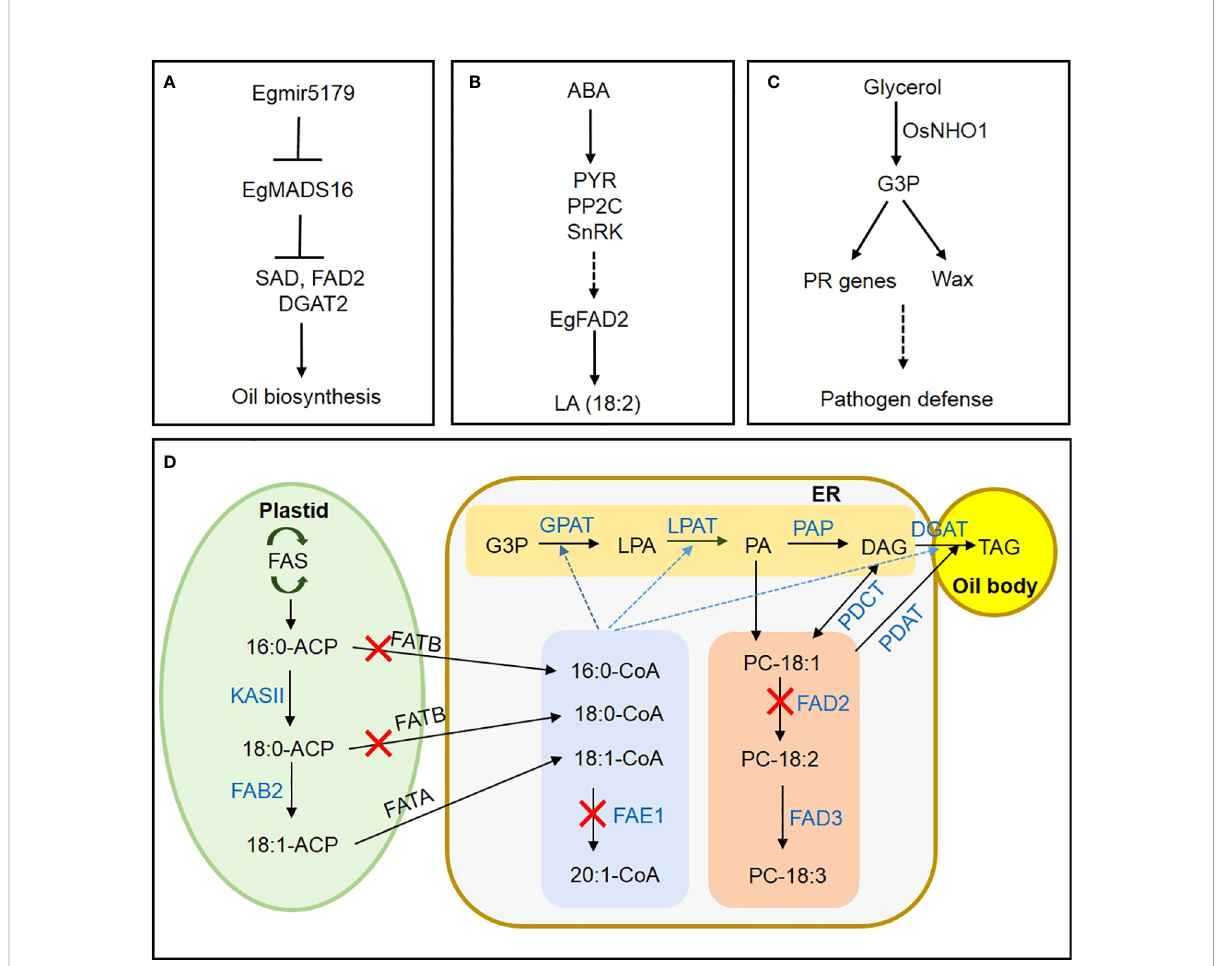
FIGURE 1 A novel mechanism for regulating lipid metabolism in oil crops and a metabolic pathway for FA and TAG synthesis in oilseeds. (A) In oil-palm mesocarp, mir5179 inhibits MADS16 expression and regulates the expression of oil synthesis genes SAD , FAD2 , and DGAT2 . (B) ABA induces linoleic acid synthesis through ABA signaling pathway in oil palm mesocarp. (C) Induction of disease resistance in rice through regulating PR gene expression and wax synthesis by glycerol kinase OsNHO1. (D) Suppression of FAE1 expression for EA-free oil crop development. Suppressing FATB inhibits saturated-FA synthesis. Suppressing FAD2 expression blocks polyunsaturated-FA synthesis, resulting in elevated production of oleic acid. Black arrows indicate the direction of FA biosynthesis and metabolism. Blue dotted arrows indicate acyl-CoA migration. Blue letters indicate enzymes involved in the metabolic pathways. Red Xs indicate enzyme inhibition. FAS, fatty acid synthase; ACP, acyl carrier protein; KAS, KASII, 3-ketoacyl-ACP synthase II; FAB2, fatty acid biosynthesis2; G3P, glycerol-3phosphate; LPA, lysophosphatidic acid; PA, phosphatidic acid; DAG, diacylglycerol; TAG, triacylglycerol; CoA, coenzyme A; GPAT, glycerol-3-phosphate acyltransferase; LPAT, lysophosphatidic acid acyltransferase; PAP, phosphatidate phosphatase; DGAT, diacylglycerol acyltransferases; PDAT, phospholipid diacylglycerol acyltransferase; PC, phosphatidylcholine; FAD2, fatty acid desaturase 2; FAD3, fatty acid desaturase 3; ER, endoplasmic reticulum; FAE1, fatty acid elongase 1; FATA, fatty acid thioesterase A; FATB, fatty acid thioesterase B; PDCT, phosphatidylcholine diacylglycerol choline phosphotransferase; PDAT, phosphatidylcholine diacylglycerol